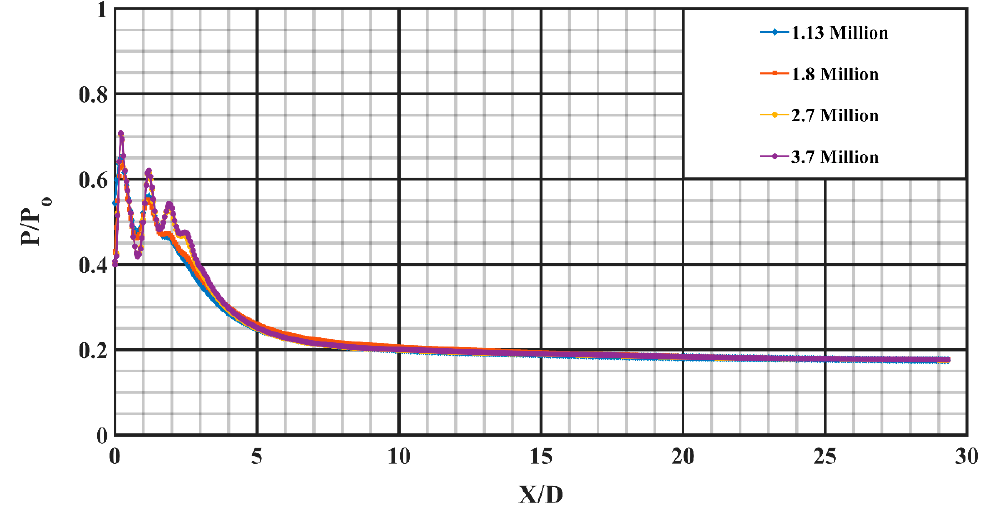
Figure 9. Grid independence test (centerline pressure decay to compare the grid resolution).